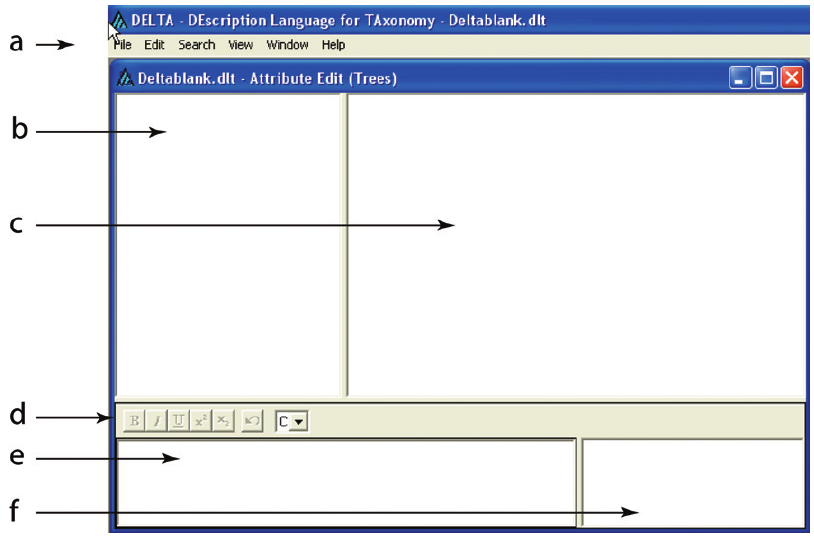
Figure 1a–f. DELTA Editor. a dropdown menus b pane for items (= taxa) c pane for characters d but- tons for formatting selections e pane showing the character state description in number form and possible additional descriptions in angle brackets f pane for character state selection with check